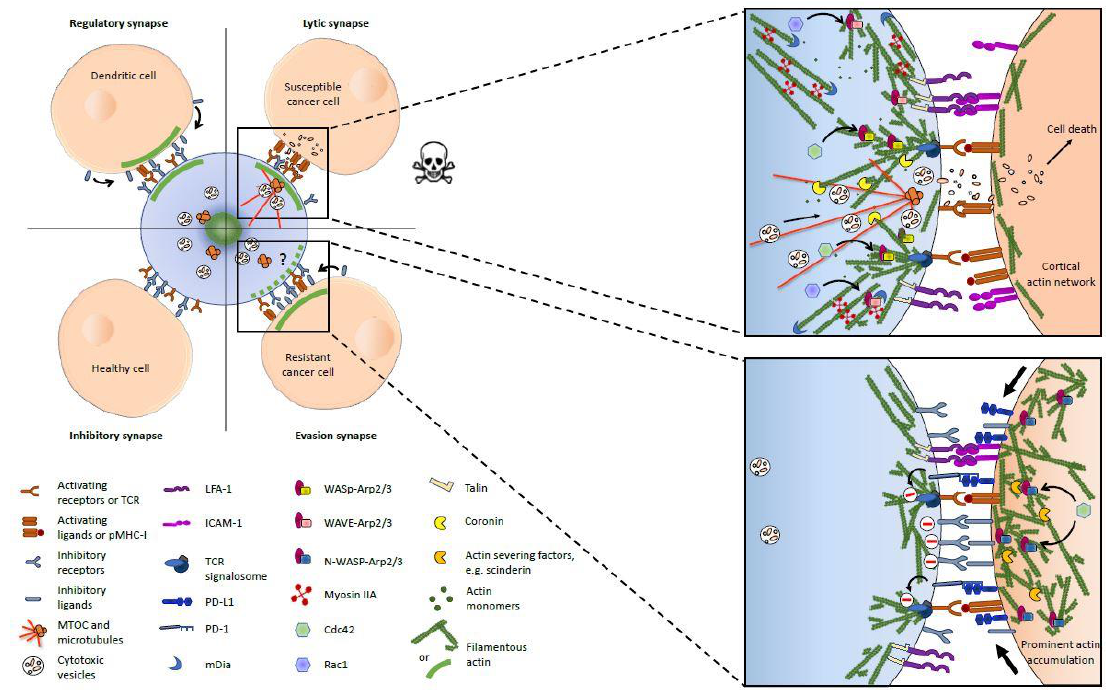
Figure 1. Actin cytoskeleton at the immunological synapses between a cytotoxic lymphocyte (blue) and its target cells. The left panel provides a general overview of the four types of immunological synapses (ISs) discussed in the article and shows the presence or absence of F-actin accumulation (large green line) on both sides of the IS (inspired from [45]). The specific actin filaments (AF) organization and some key upstream regulators, as well as the functions of AFs in intercellular signaling are depicted in the right panels for the lytic (upper panel) and evasion (lower panel) synapses. The reader should pay attention that the provided information sometimes originates exclusively from studies based on either natural killer (NK) cells or cytotoxic T lymphocytes (CTLs) and is invited to refer to the main text for more details.